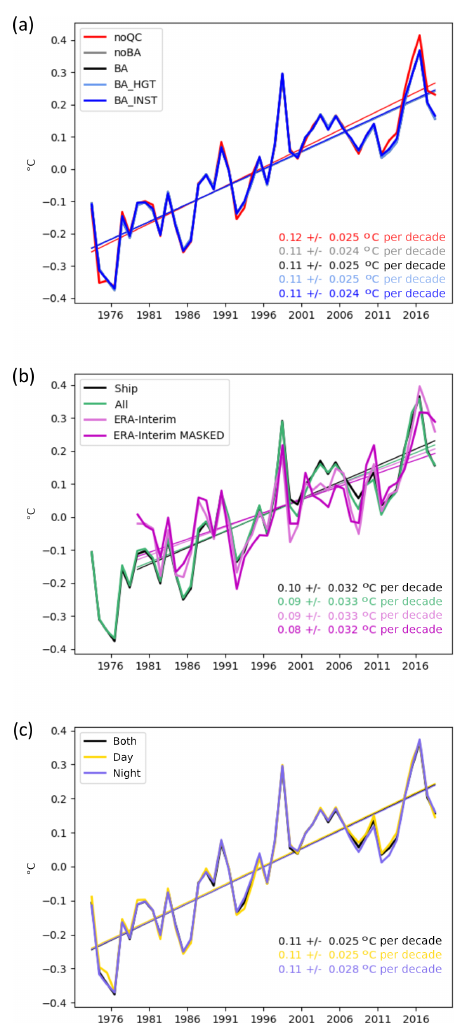
Figure 10. Global annual average anomaly time series and decadal trends ( ± 90% confidence interval) for dew point temperature. See Fig. 8 caption for details. Trends in (b) cover the common 1979– 2018